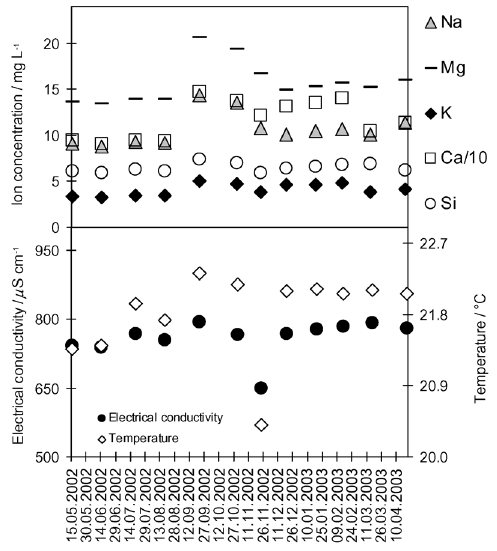
Fig. 3. Ion concentrations (mgL –1 ), electrical con- ductivity ( µ cm –1 ) and water temperature (°C) in the thermal spring at Zatolmin between May 2002 and April